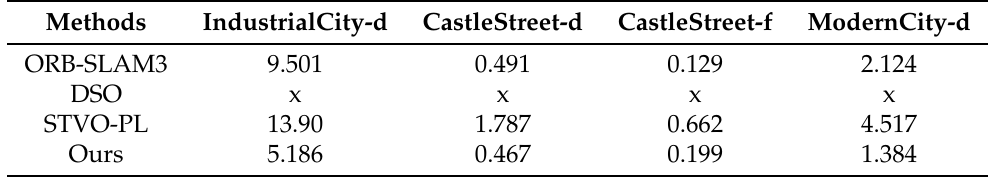
Figure 10. Illustration of collecting images using Airsim. On the left, various scenes are displayed; in the middle, an example of the drone crossing the scene is shown; and, on the right, an example of some collected image sequences is given. Table 1. Comparison of RMSE (m) on simulation data set. ‘-d’ stands for downward and ‘-f’ stands for forward, ‘x’ indicates no trajectory or too short trajectory using this